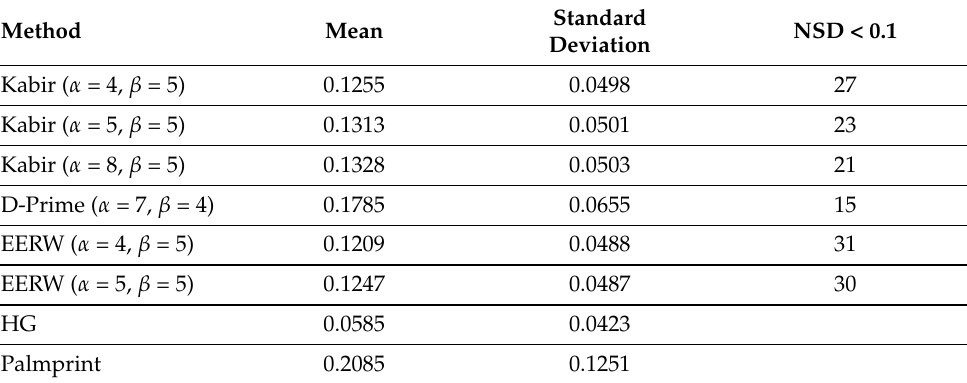
Table 6. Mean, Standard Deviation and occurrences of NSD < 0.1 for the distributions of Figure